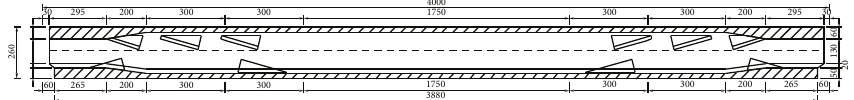
Figure 19: Longitudinal section of optimized 40 m box girder